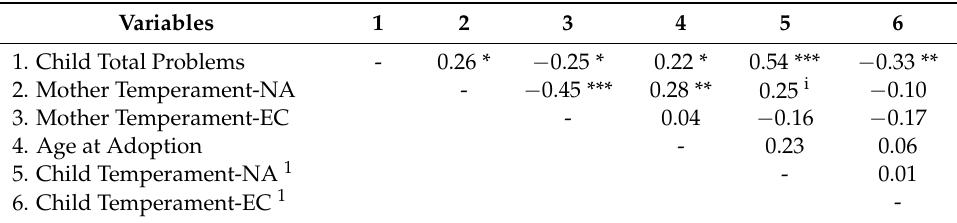
Table 2. Zero-order correlations for study